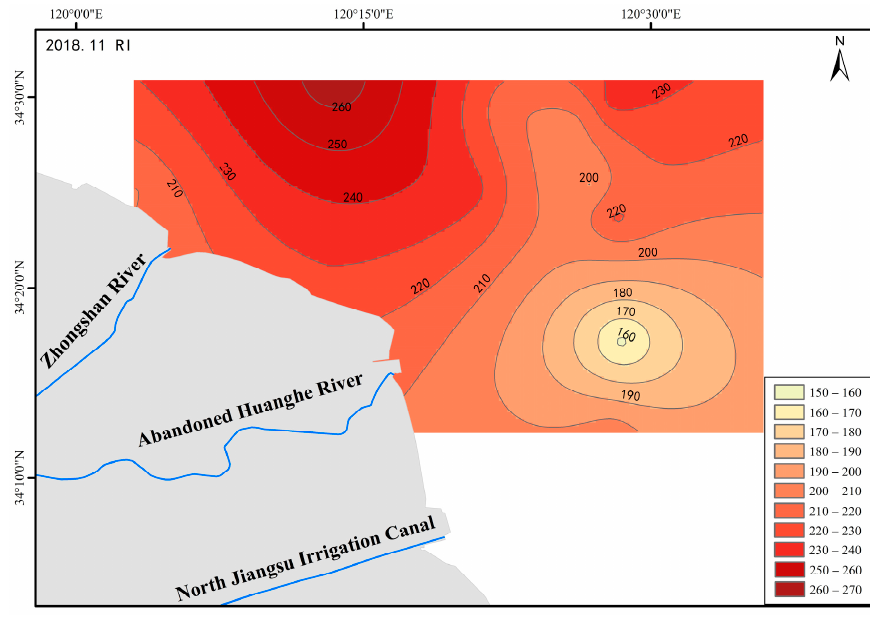
Figure 4. Distribution map of the comprehensive potential ecological risk index in 2018.